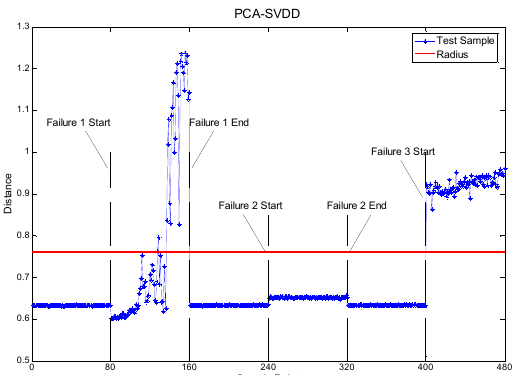
Figure 5. Fault detection with PCA.